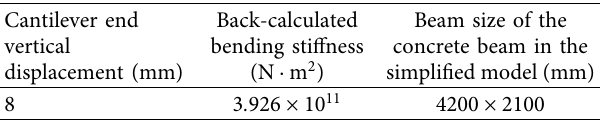
Table 10: Dimension of the beam in the simplified